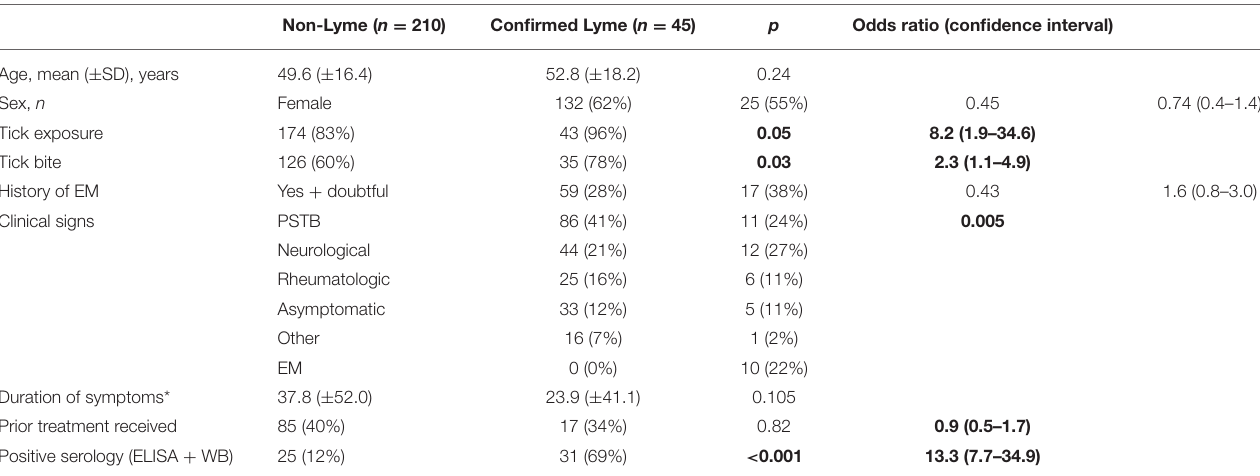
TABLE 5 | Comparison between confirmed Lyme group and Non-Lyme